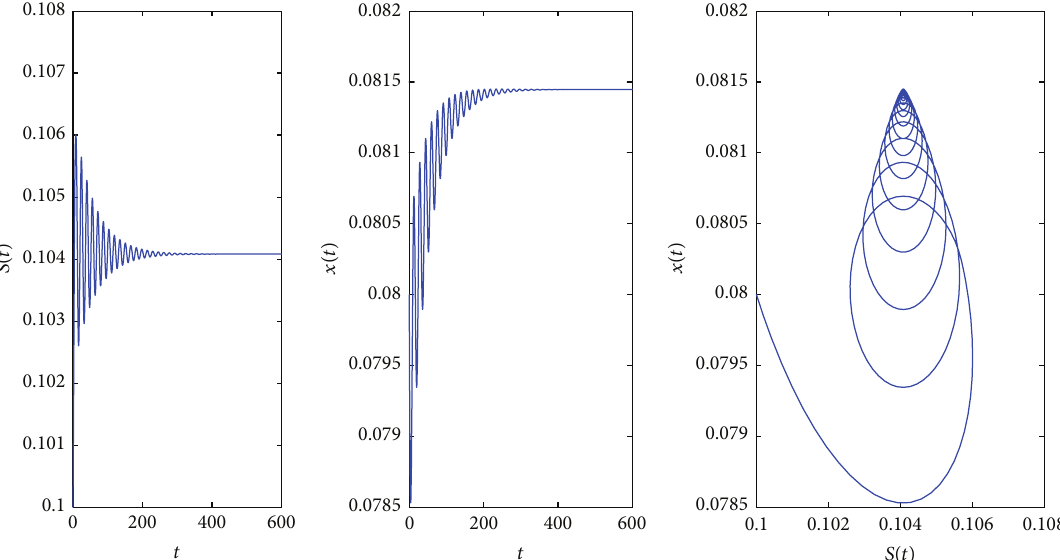
Figure 2: Asymptotic stability. The steady state 𝐸 ∗ of (1) is locally asymptotically stable, even though damped oscillations can be observed. The parameters are 𝐷 = 0.01 , 𝐷 1 = 0.5 , 𝛾 = 0.8 , 𝑘 = 0.1 , 𝑎 = 1 , and 𝑆 0 = 1 . The time delays are 𝜏 1 = 0 and 𝜏 2 = 10